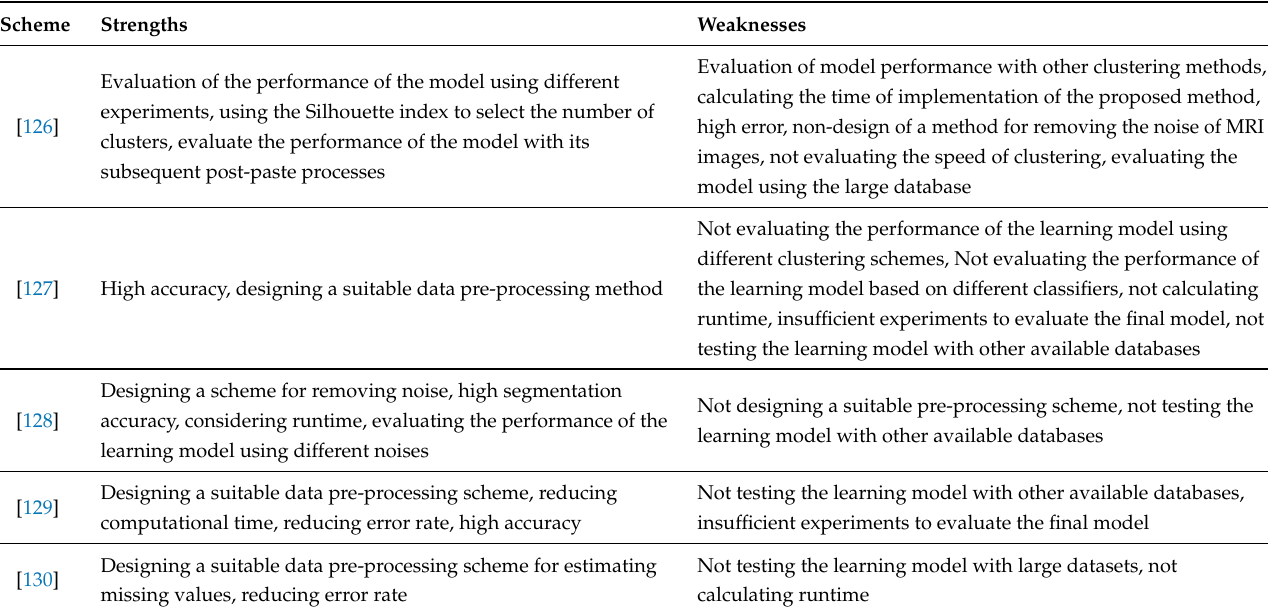
Table 15. The most important strengths and weaknesses of unsupervised learning-based